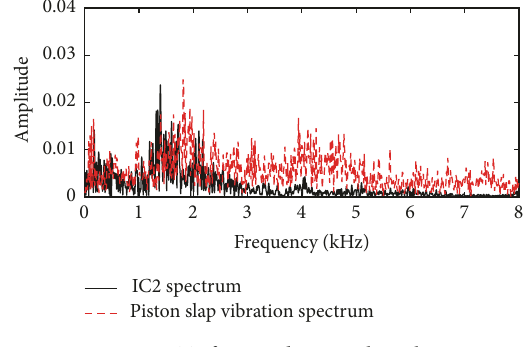
Figure 23: FFT of IC2 and piston slap vibration.